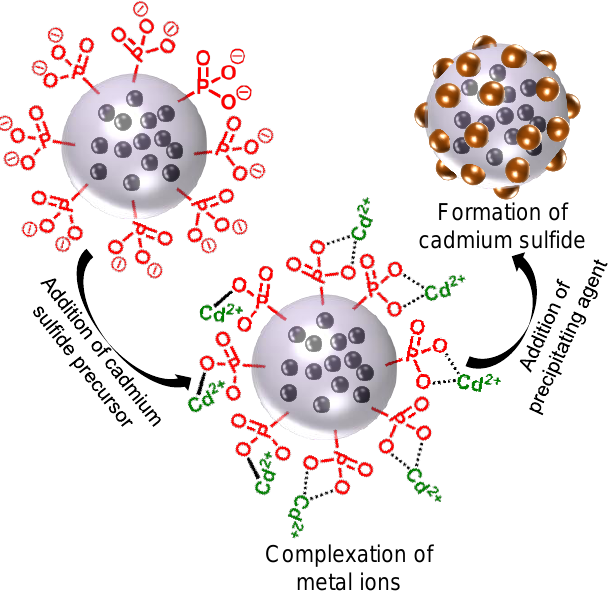
Figure 9. Mechanism of metal chalcogenide formation at the surface of phosphonate functionalized latex particles with magnetic iron oxide core. Reprinted with permission from [108]. Copyright 2013, American Chemical